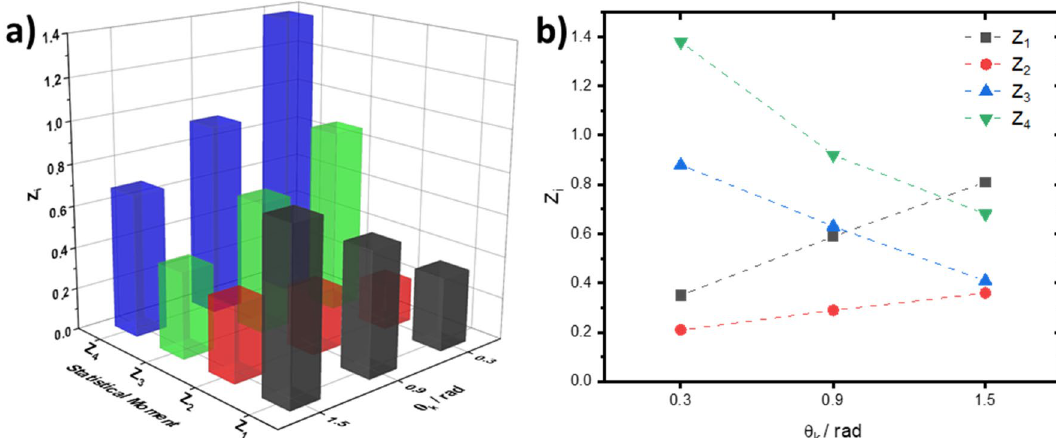
Figure 3. The statistical moments of the first to fourth orders, as calculated in three phase sections of a embossed topographic depolarisation map of a myocardial tissue sample. Data was plotted in OriginPro 2020 (www.origi nlab.com).